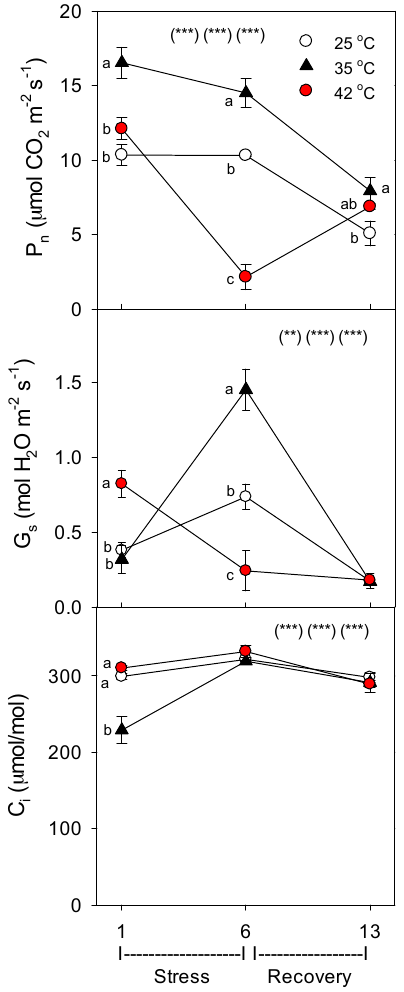
Figure 2. Effect of abrupt heat stress on net photosynthesis (P n ), stomatal conductance (G s ), and leaf internal CO 2 concentration (C i ) of tomato. Plants were grown at 25 ◦ C/20 ◦ C day/night (control), and then subsets of plants were heat stressed at 35/30 or 42 ◦ C/37 ◦ C day/night for one or six